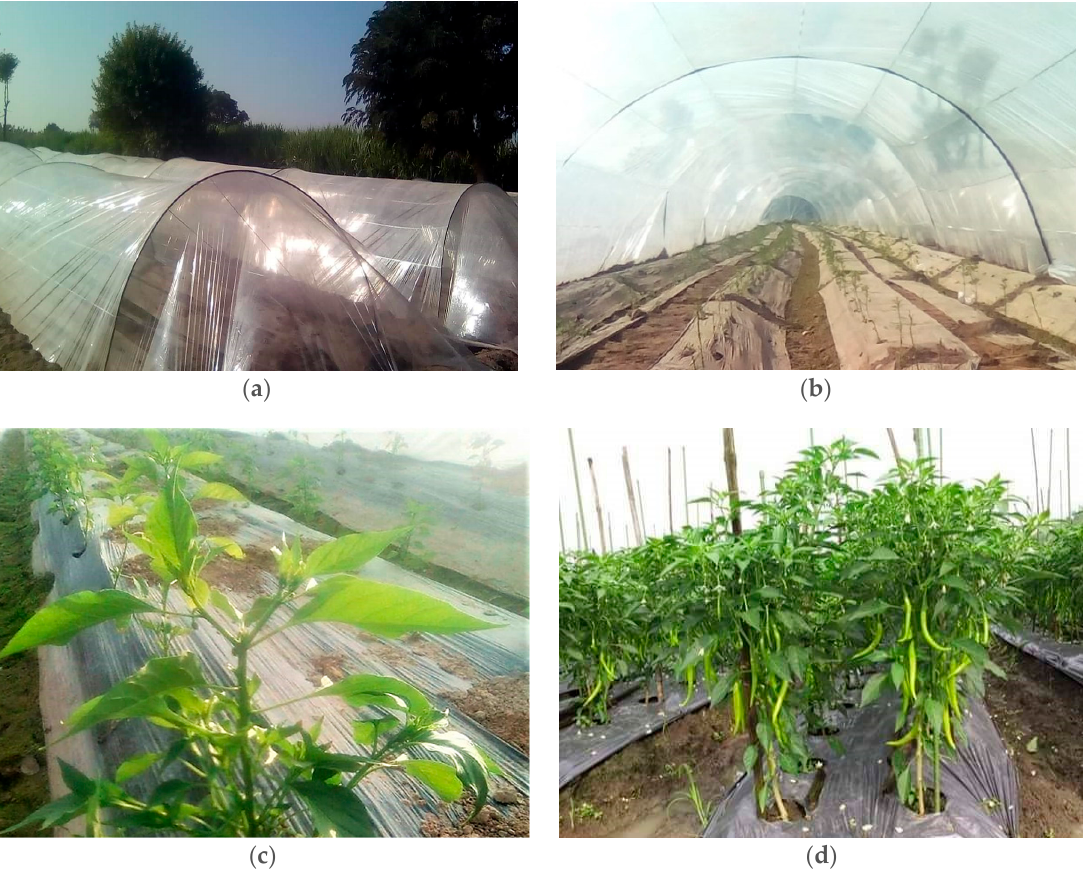
Figure 9. Test bed of the smart irrigation system. ( a ) external view; ( b ) tiller phase (15 days); ( c ) mid-age plant (50 days); ( d ) mature age plant (100 days).